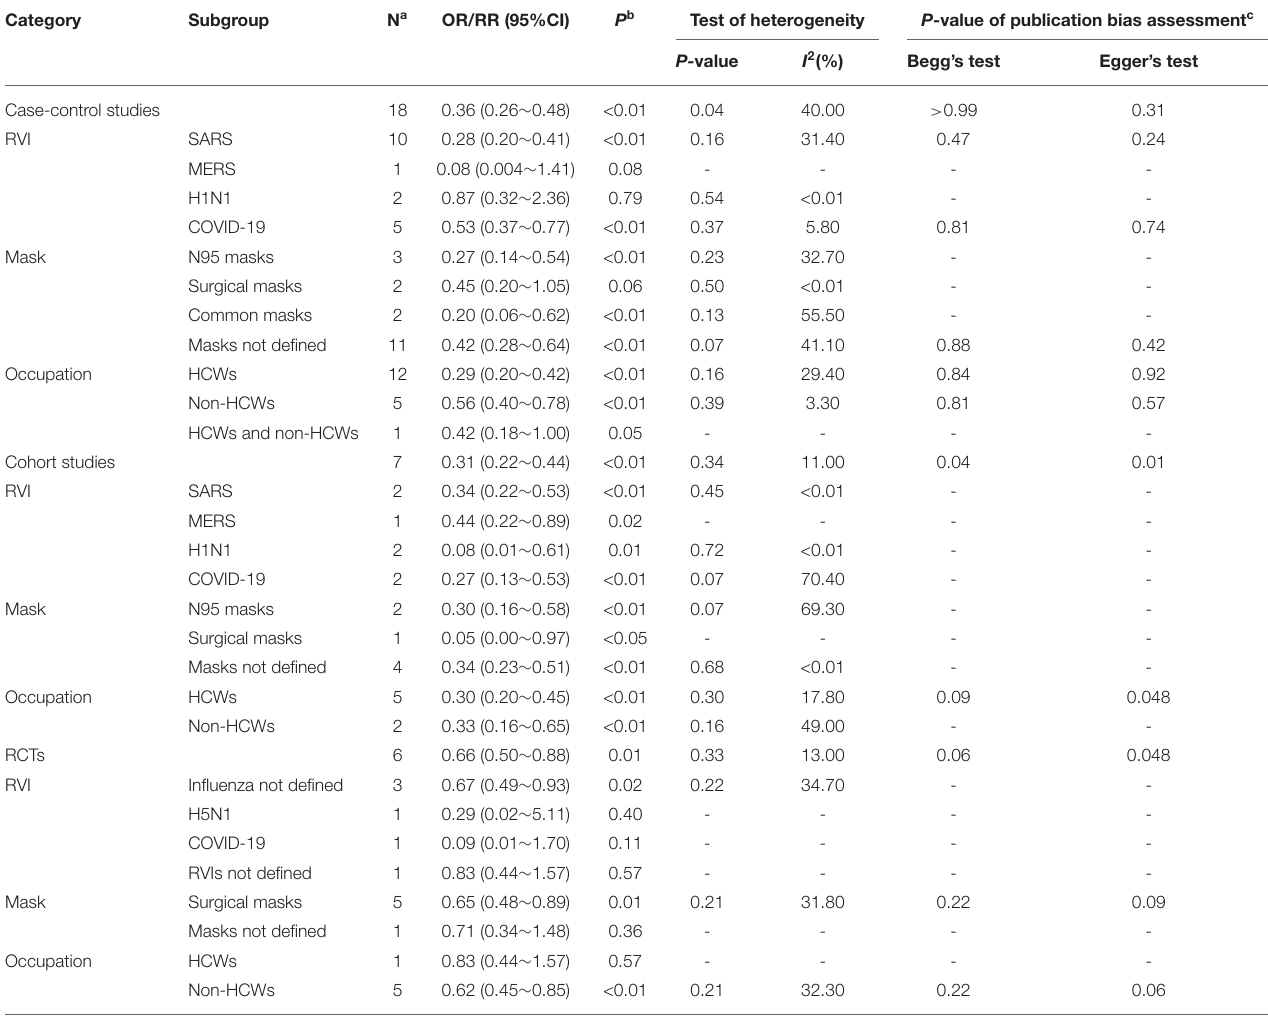
TABLE 2 | The results of